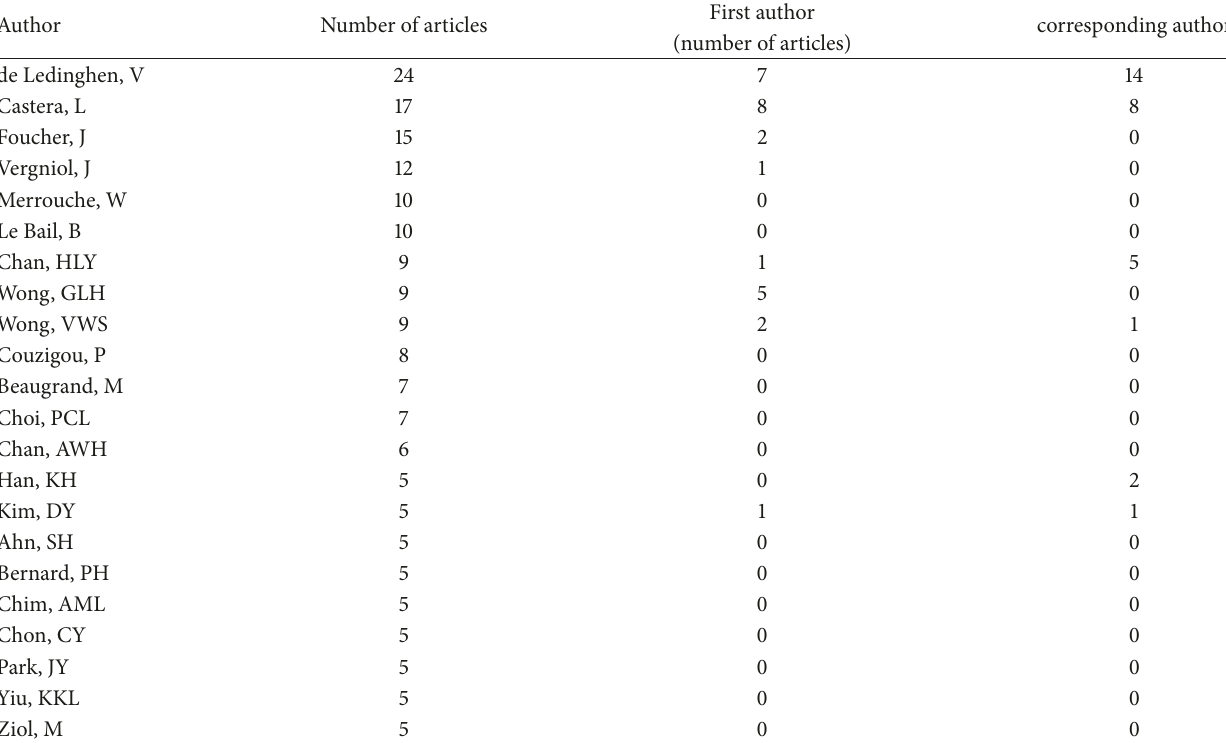
Table 2: The authors with more than five articles in the 100 most-cited articles on transient